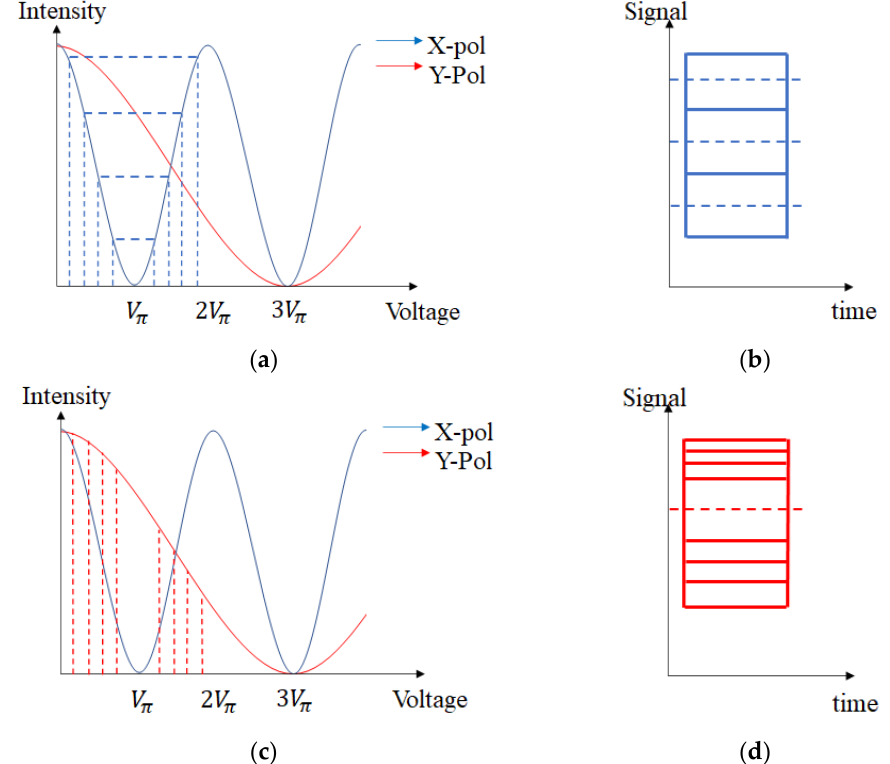
Figure 2. Transfer curve and expected eye-diagram for each polarization axis: ( a ) X -axis voltage vs. intensity transfer curve; ( b ) Expected X -axis eye diagram ( c ); Y -axis voltage vs. intensity transfer curve ( d ); Expected Y -axis eye diagram.